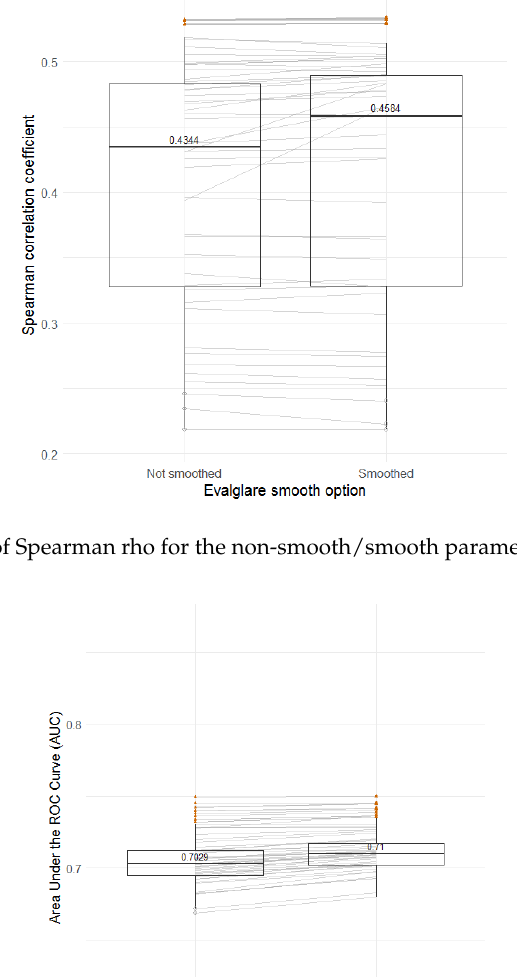
Figure 32. Boxplots of Spearman rho for the non-smooth/smooth parameter (field study).